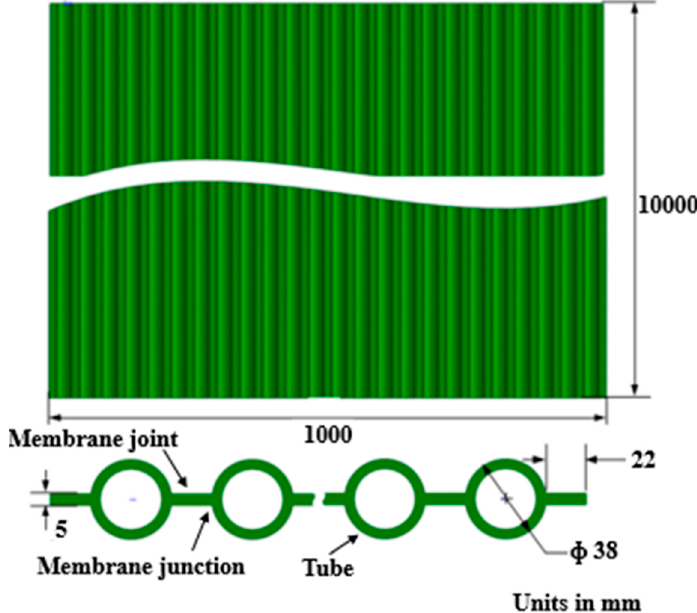
Figure 1. Schematic diagram of the boiler tube’s wall.